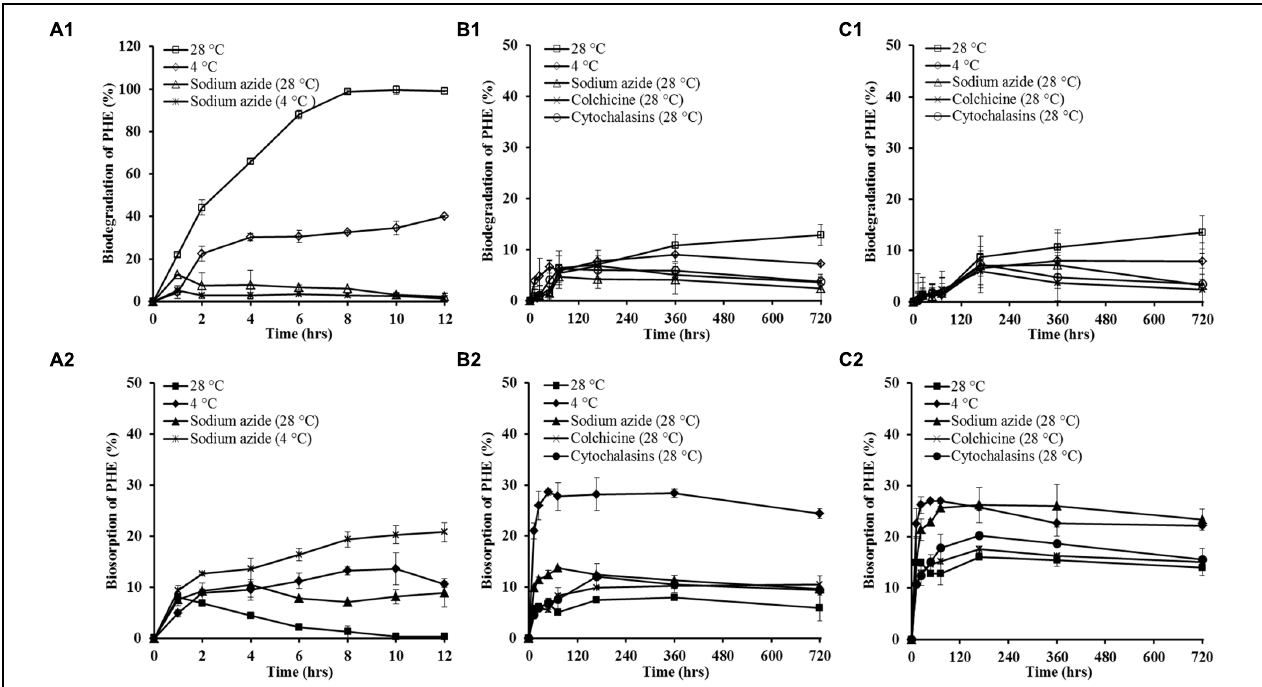
FIGURE 4 | The percentage of PHE biodegradation and biosorption by Massilia sp. WF1 (A1,A2), spore (B1,B2), and mycelial pellet (C1,C2) of P. chrysosporium under different inhibition treatments. Bars are ± standard deviation of five